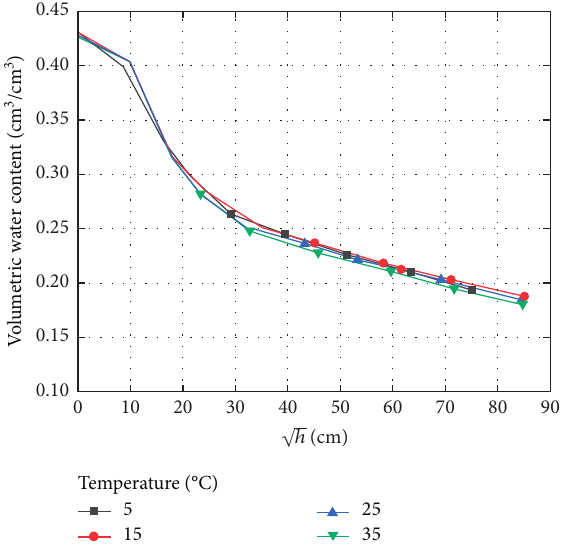
Figure 3: SWCC of loess with 1.5g/cm 3 dry density at a tem- perature of 5, 15, 25, and 35 °